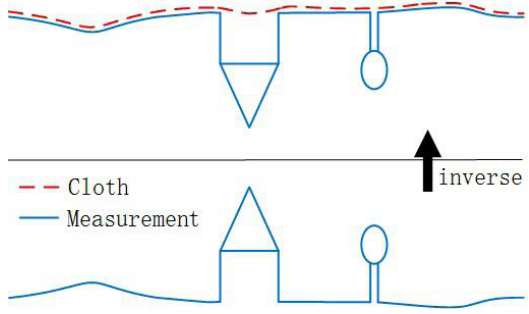
Figure 1. An overview of the cloth simulation algorithm